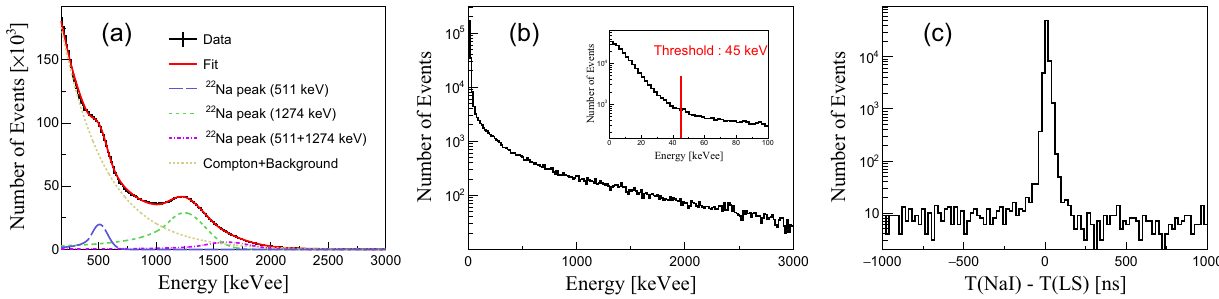
Fig. 18 a 22 Na calibration spectrum of the LS is modeled with known γ peaks. b Background energy spectrum of the LS is presented. Inset shows zoomed spectrum at the low energy and presents a 45keV energy threshold for the multiple-hit requirement. c Time differences between